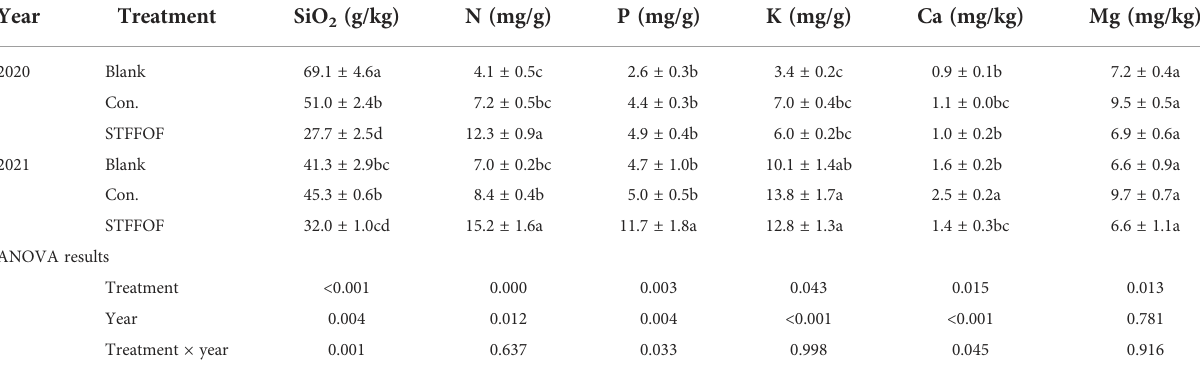
TABLE 4 Effects of soil-testing formula fertilization using organic fertilizer for 11 years on the mineral elements of rice